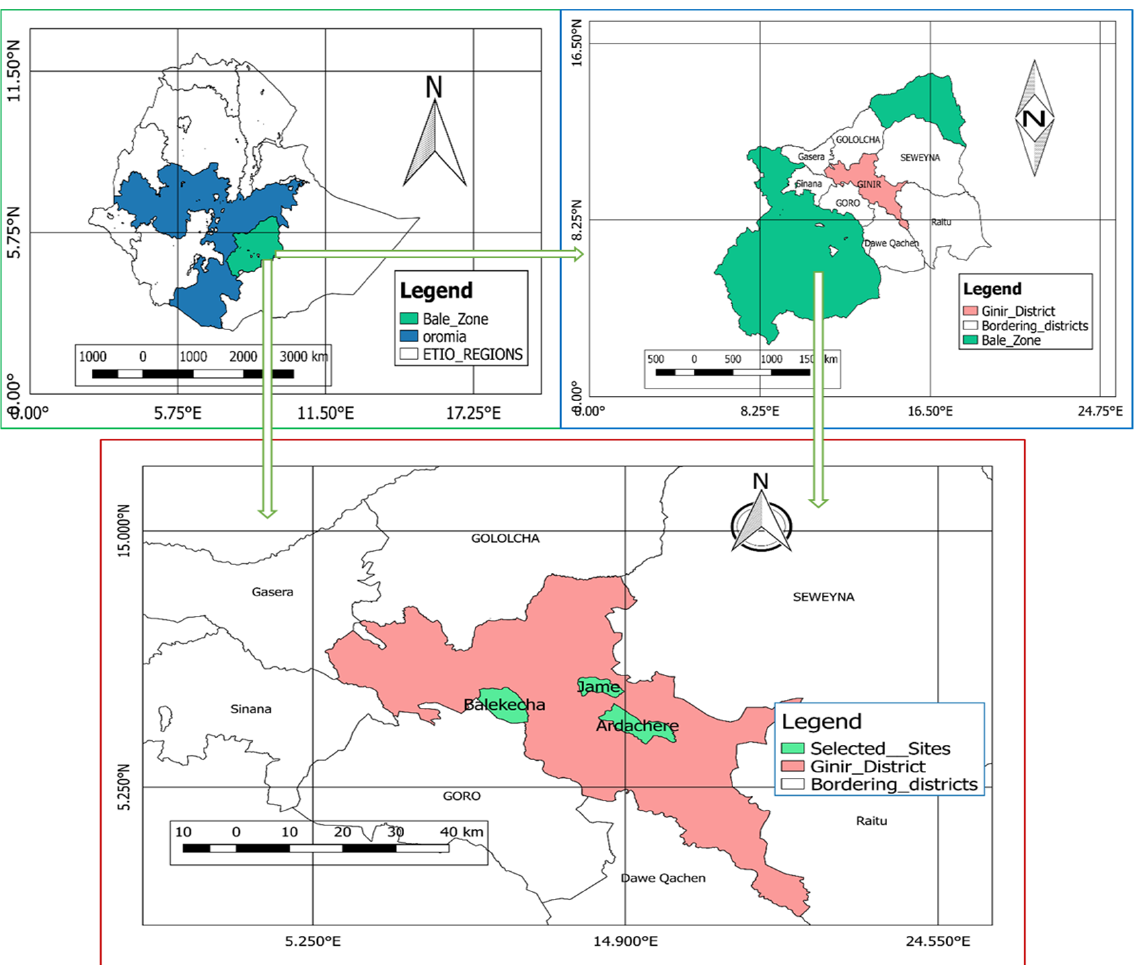
Figure 1. Location map of the study area.